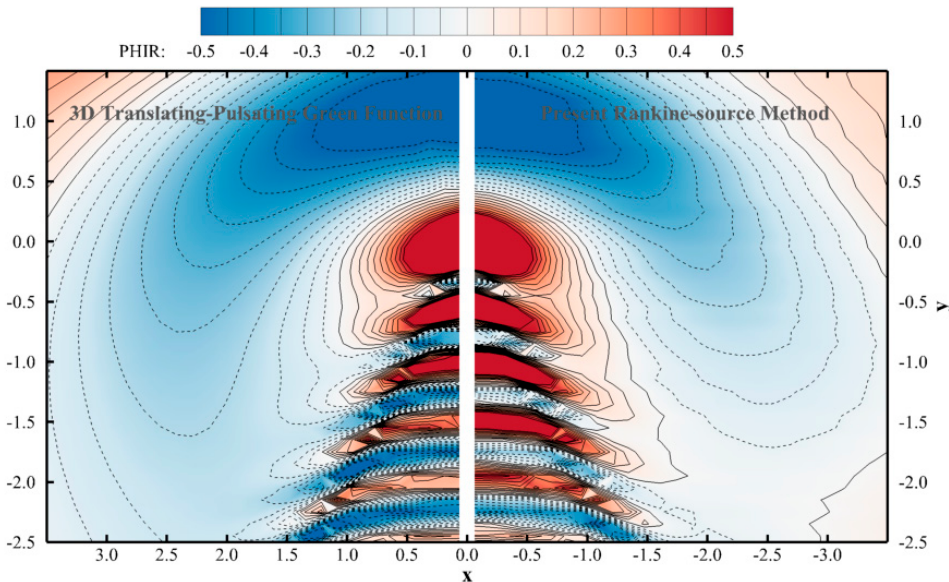
Figure 9. R [ ϕ ] by Green function and Rankine source methods at κ L = 1.0, F r = 0.2, τ = 0.2 and with Rayleigh damping μ c = 0.6 [39].